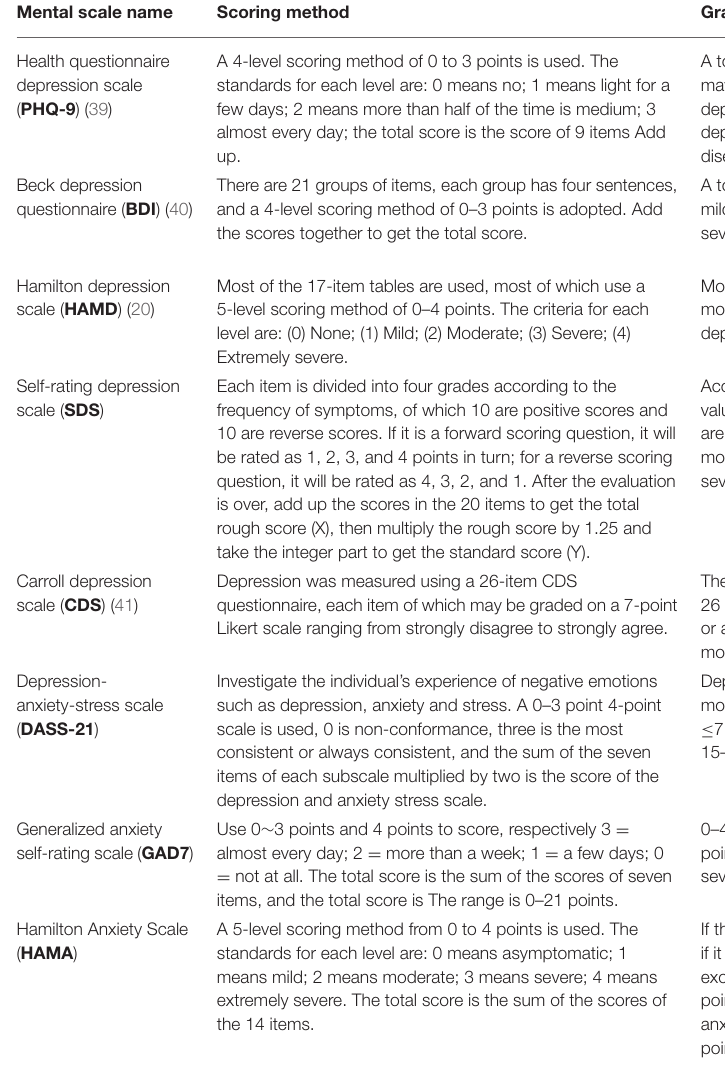
TABLE 5 | Application of different psychological